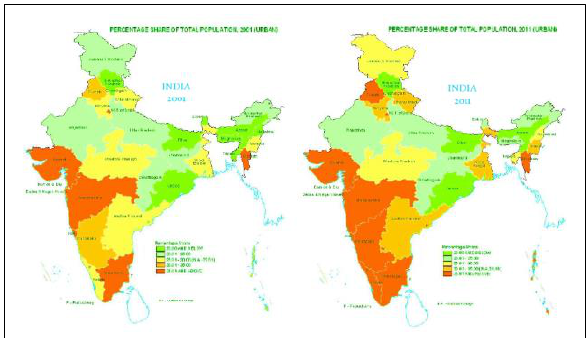
Table 3. Towns and Cities based on Population Size in India: 1981 to 2011.